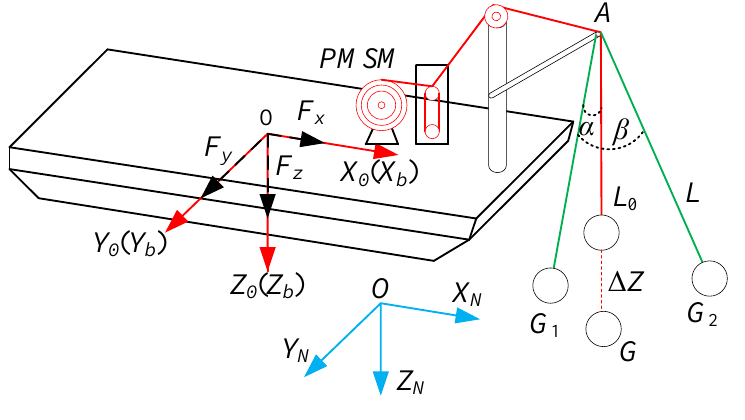
Figure 5. Ship crane system model.